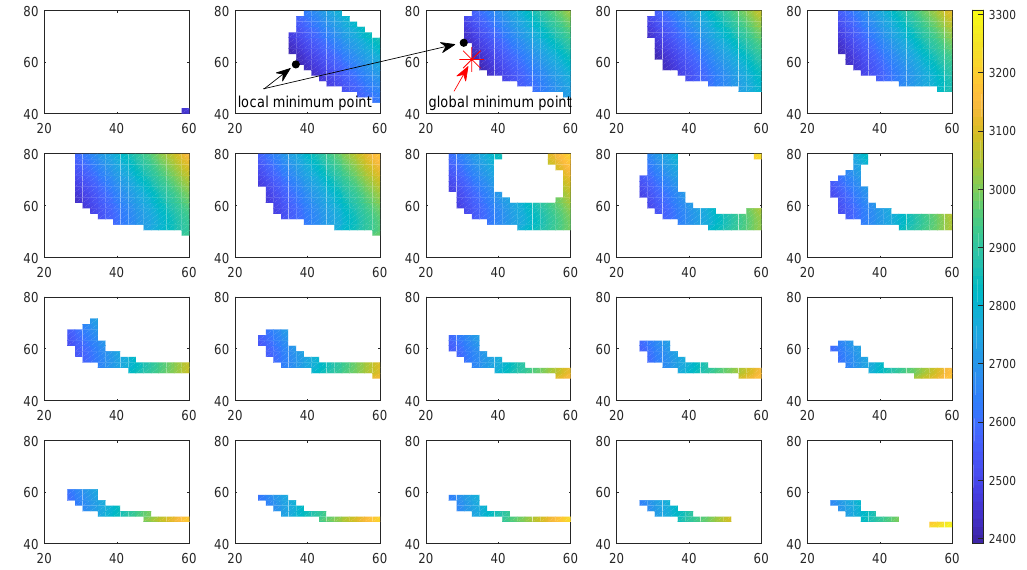
Figure 9. Distributions of the total power consumption for twenty values along z